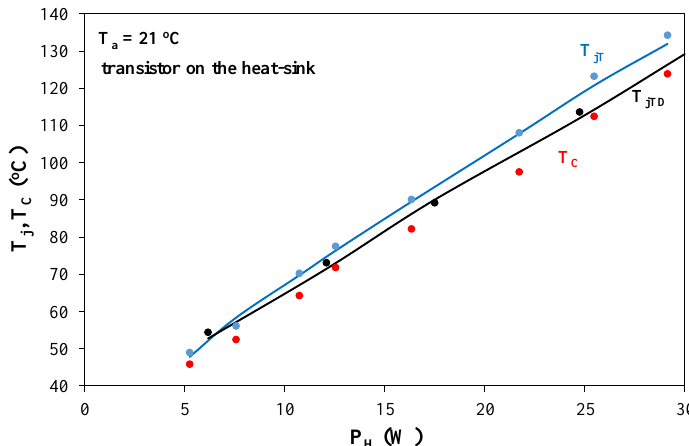
Figure 11. Measured and computed dependences of internal temperatures of the dies and the case temperature of the investigated device situated on the heat-sink on heating power dissipated in it at the steady state.